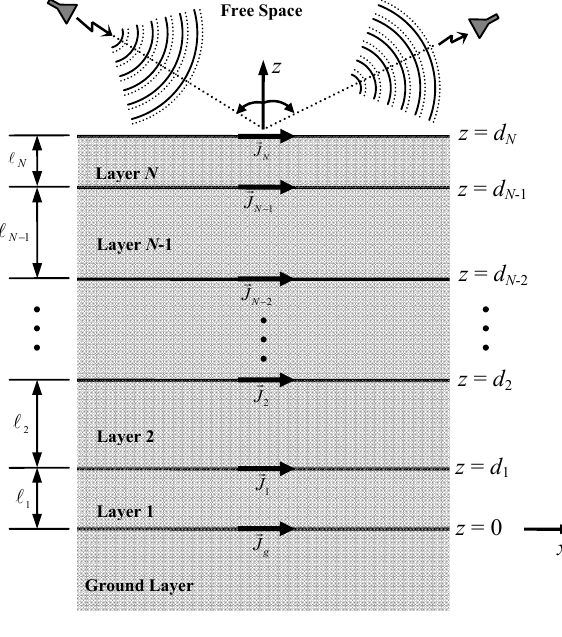
Figure 1. Geometry of the planar structure with N + 2 layers (lateral